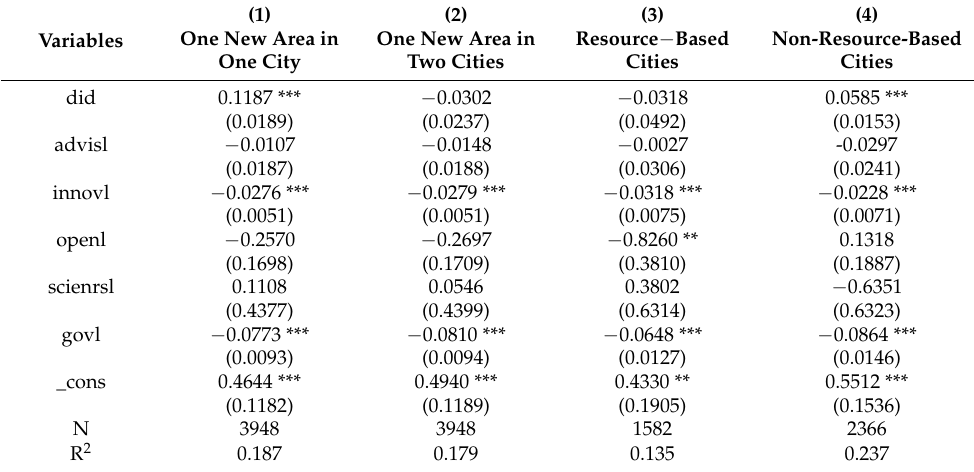
Table 9. Results of layout model of national new areas and different types of